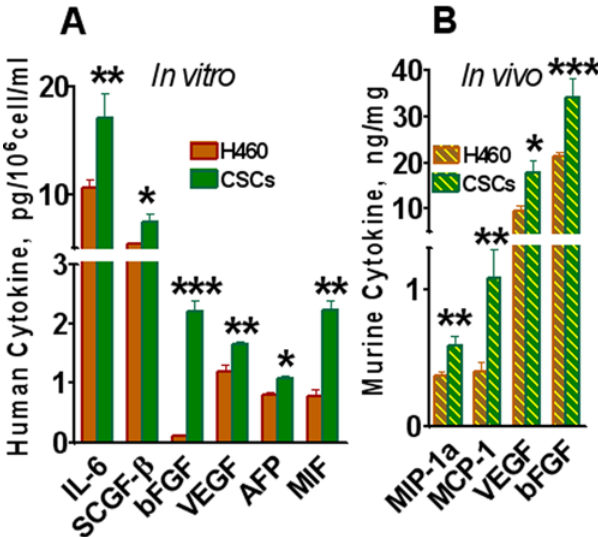
Figure 7. Multiplex analysis of cytokines. A, In vitro cytokine production by CSCs and parental human tumor H460 cells. Cells were cultivated in 96-well plates for 24 h in complete RPMI 1640 medium; samples of conditioned media were collected. Cells were fixed, stained with Hoechst 33342, and cell numbers were determined using image cytometry. Concentrations of human cytokines, chemokines, growth factors, MMPs, adhesion molecules and cancer antigens were analyzed using Luminex technology. Concentrations of cytokines pg/10 6 cells/ml were calculated. Only factors with significant differences in their concentrations are presented. B, Analysis of murine cytokines in extracts of xenografted parental H460 and CSCs-derived tumors. SCID mice were inoculated s.c with 5 6 10 5 of parental H460 or CSCs (5 mice per group). Samples of tumors, derived from parental H460 cells and CSCs, were sonicated, and concentrations of 19 murine cytokines in cellular extracts were measured using multiplexed cytokine assays as described in Materials and Methods. Only factors with significant differences in their concentrations (at least p , 0.05) are included. Results are presented as pg or ng of cytokine per mg of total tumor